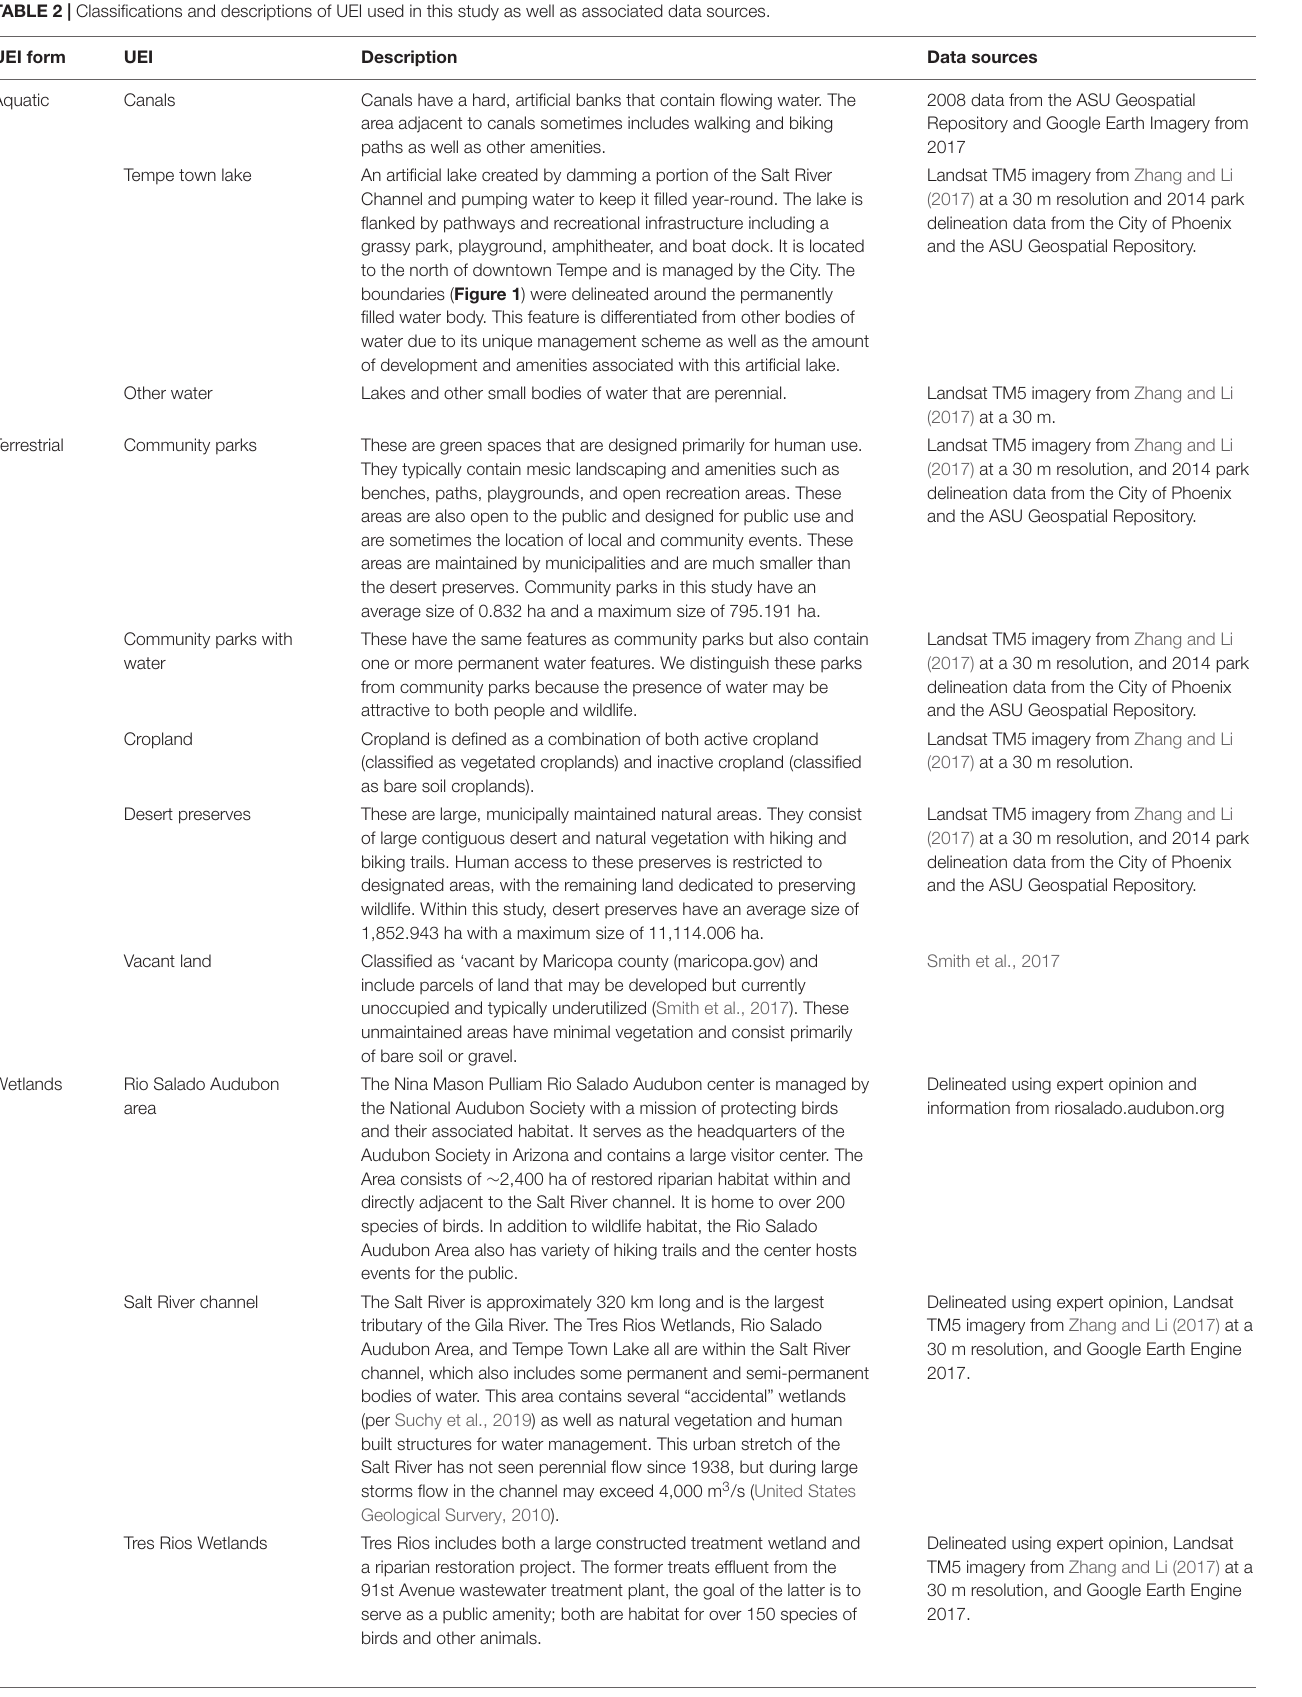
TABLE 2 | Classifications and descriptions of UEI used in this study as well as associated data